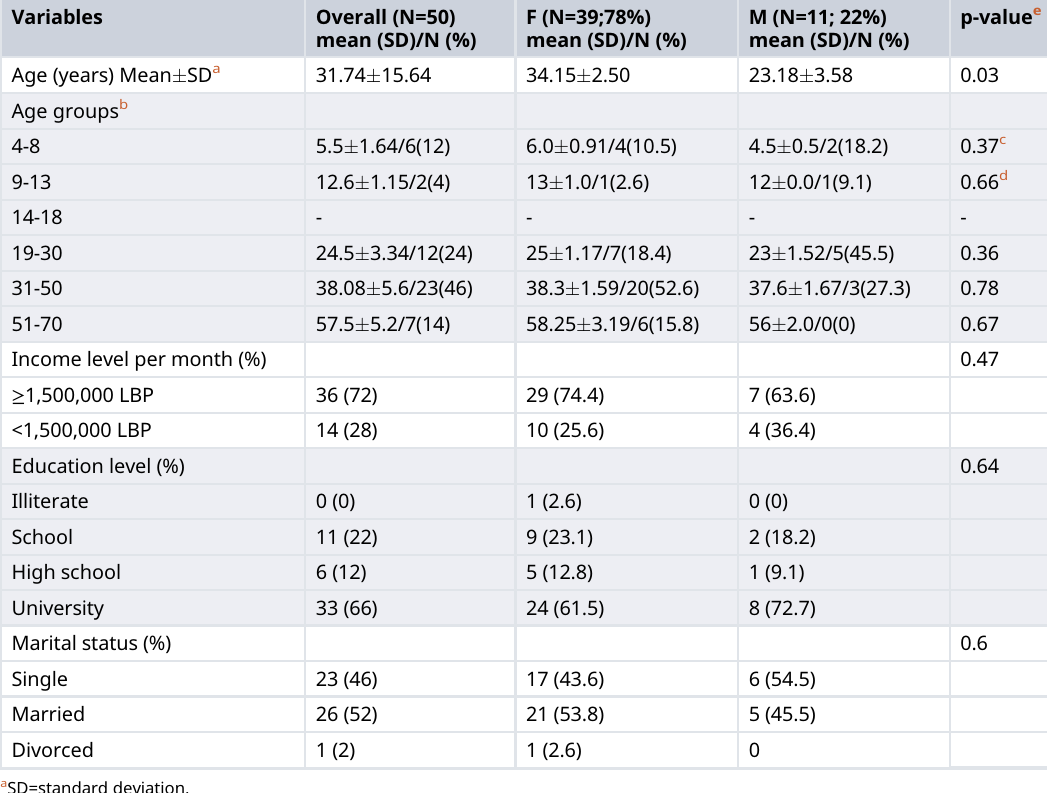
Table 1. Socio-demographic characteristics of biopsy-proven study population, overall and by gender. LBP: Lebanese Pounds. Variables